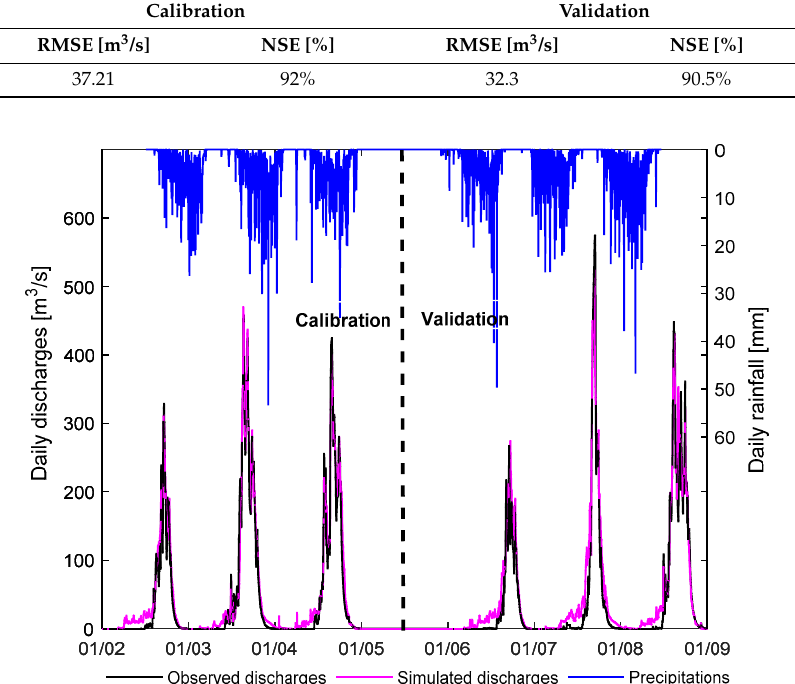
Figure 8. Comparison between simulated and observed hydrographs. Table 4. Model calibrated